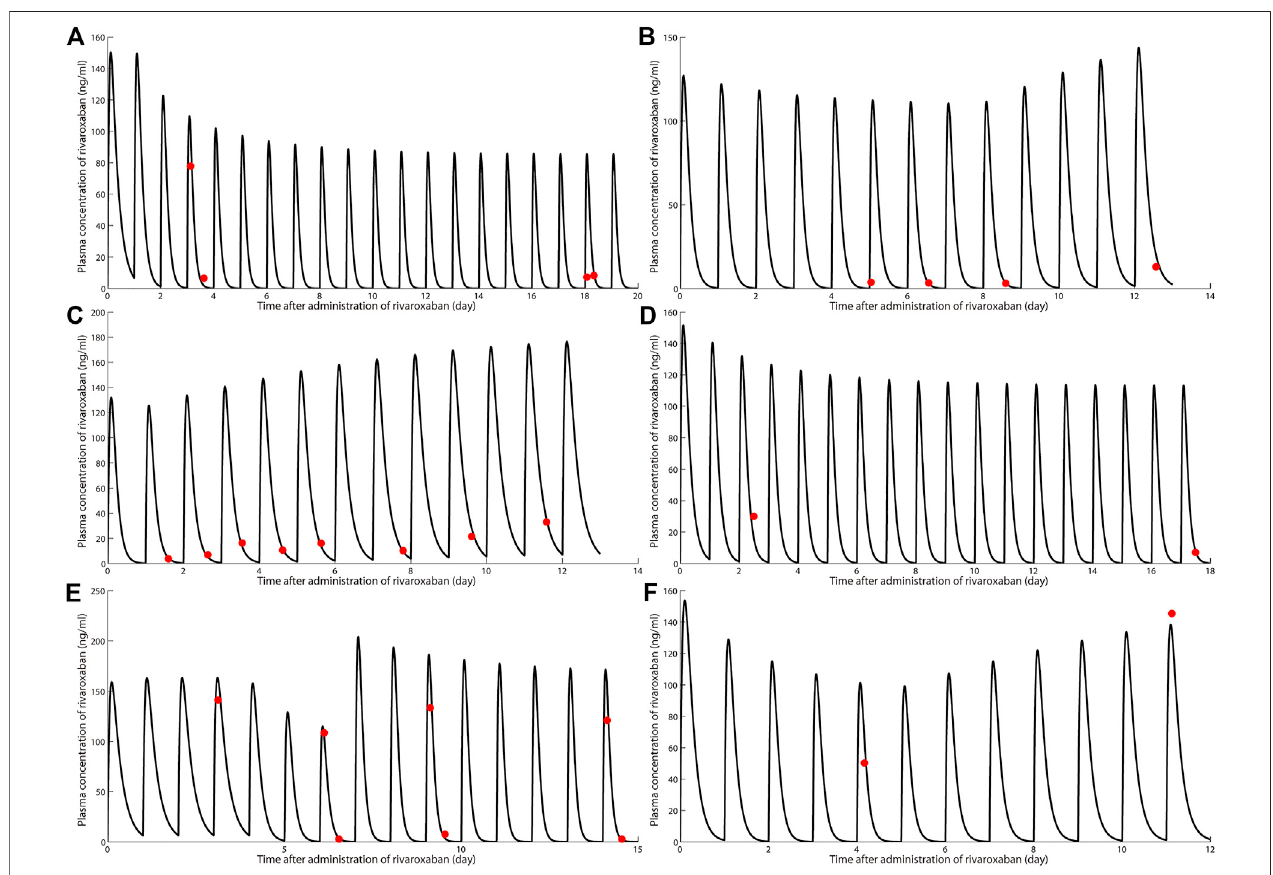
FIGURE1| Simulationofpharmacokineticpro fi lesofrivaroxabanwithorwithoutrifampinindifferentdosingregimens.Predictionoftheconcentration-timecourses of rivaroxaban in the present patient cases (A – F) . The line represents the prediction and the dot presents the observed value.